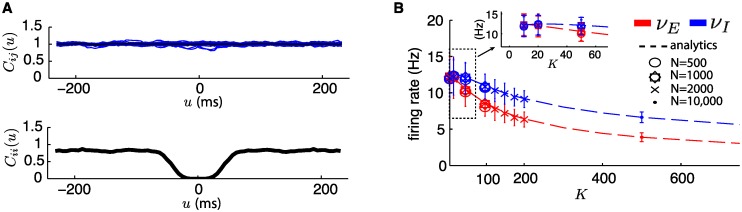
(A) Top: Typical normalized spike-time cross-correlogram Cij(u): expected proportion of pairs of spikes separated by u ms, for random pairs of neurons within the network. In blue: for 30 individual pairs; in black: average. Bottom: Typical normalized spike-time auto-correlogram Cii(u) for a neuron in the network. The QIF dynamics impose a relative refractory period close to spiking which gives a departure from purely Poisson firing statistics (notice the dip toward time 0). Typical Fano Factors are between 0.77 and 1. For A and B, N = 500, K = 20; however, the shape of these functions is not affected by N or K. Statistics sampled over network simulations of 300 seconds. (B) Mean firing rate of E and I neurons within the network as a function of K. Dotted line shows MF estimate (see Eq 8). Various markers show estimates sampled from all neurons in simulated networks of different sizes N. Error bars show one standard deviation. Inset shows zoom for low-K values.